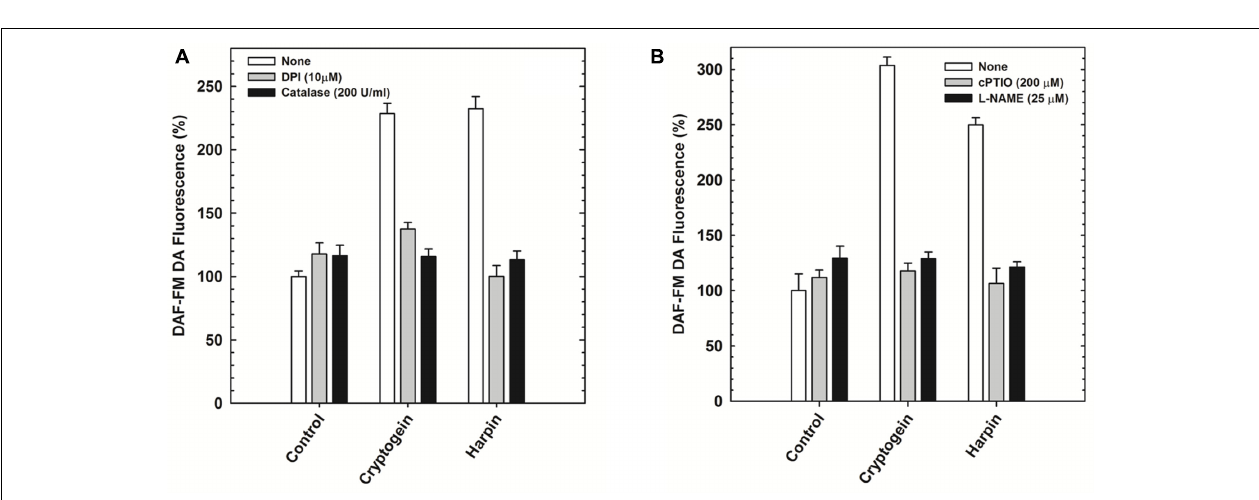
FIGURE 6 | The effect of ROS/NO modulators on the NO production in the guard cells in response to cryptogein or harpin. The levels of NO were indicated by the fluorescence of DAF-FM DA. The ROS modulators, catalase, and DPI restricted the rise of NO in the guard cells when treated with the two microbial elicitors (A) . NO modulators, cPTIO and L -NAME relieved the effect of elictors on NO production, where as the rise in NO were observed in the guard cells treated with cryptogein and harpin alone (B) . Further details are as in Figure 3 .